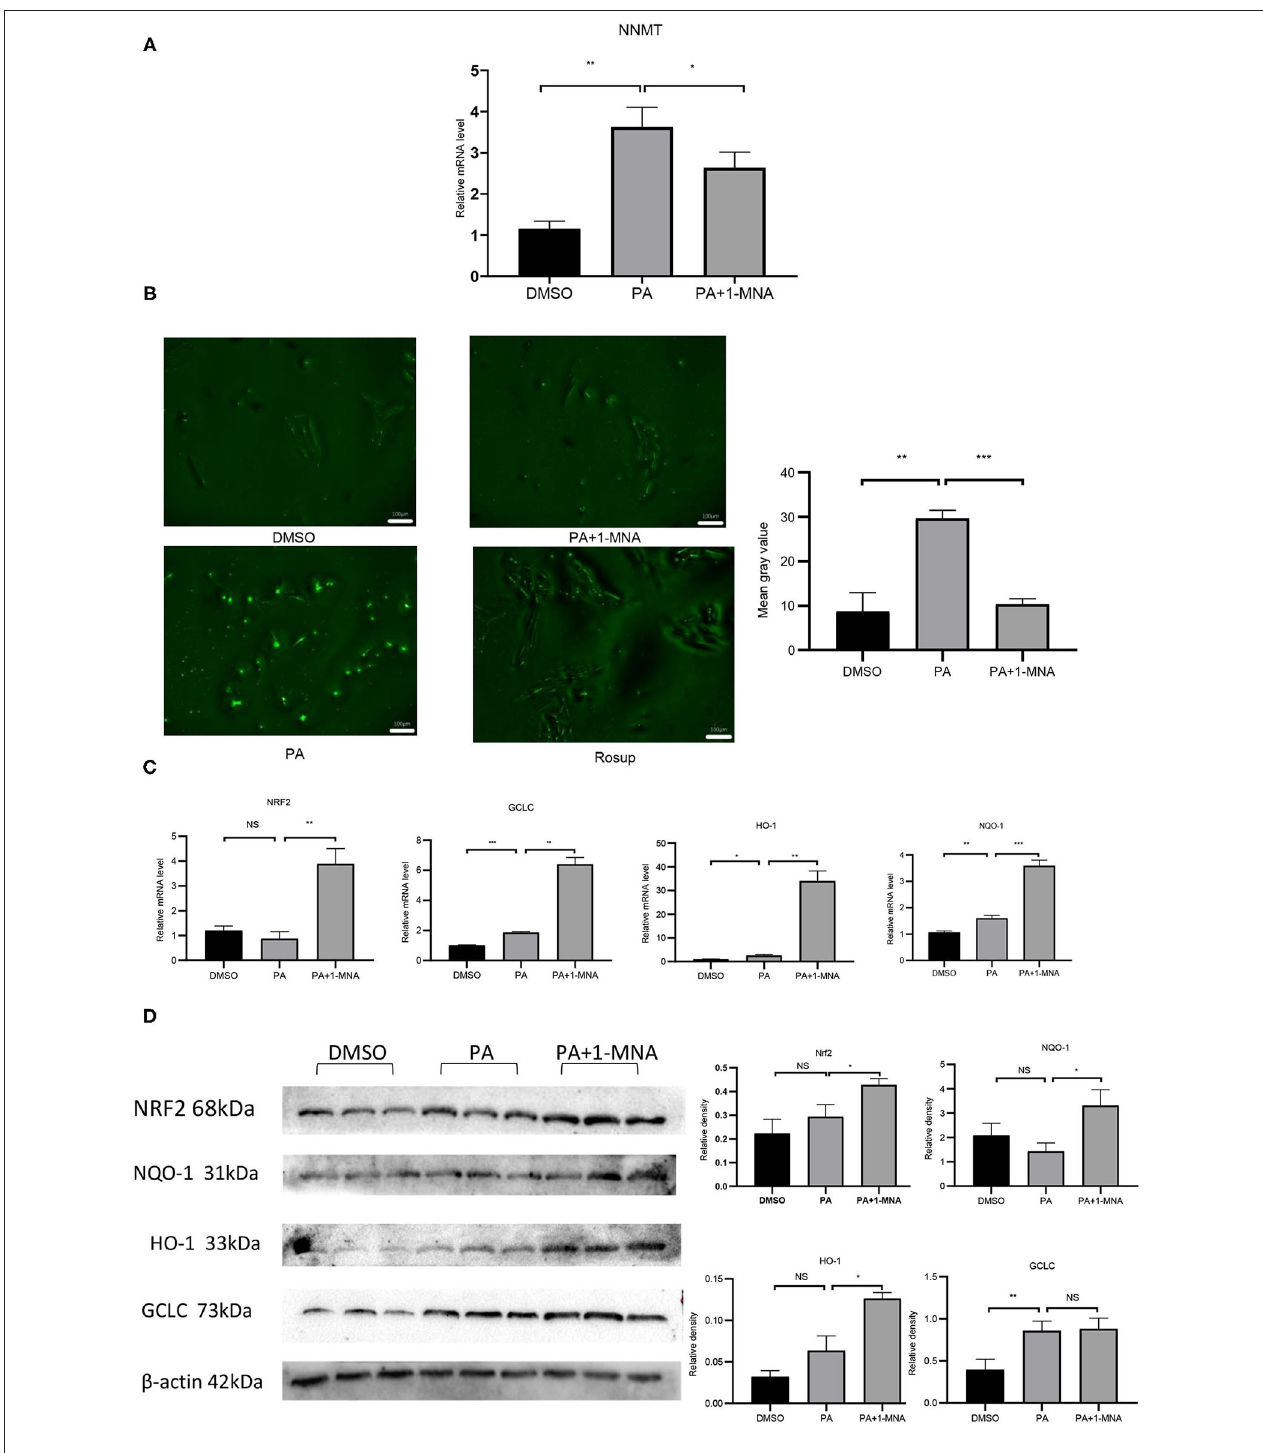
FIGURE 1 | Effects of 1-MNA on PA-induced Oxidative stress in H9C2 cells. (A) Real-type quantitative polymerase chain reaction analysis of mRNA expression of NNMT in the H9C2 cells. β -actin was taken as an internal control gene. Expression values are expressed as the mean ± SEM. (B) 1-MNA inhibits PA-induced ROS production. Immunofluorescence images of the PA group. The histogram shows the normalized intensity from three independent experiments. (C) qRT-PCR analysis of Nrf2, HO-1, GCLC, and NQO-1 expression. (D) Western blotting analysis of Nrf2, HO-1, GCLC, and NQO-1. β -actin was taken as an internal control gene. Expression is expressed as the mean ± SEM. Differences in expression were analyzed by the unpaired Student ′ s t -test and one-way ANOVA ( n = 3, NS = no significance, * P < 0.05, ** P < 0.01, *** P < 0.001).